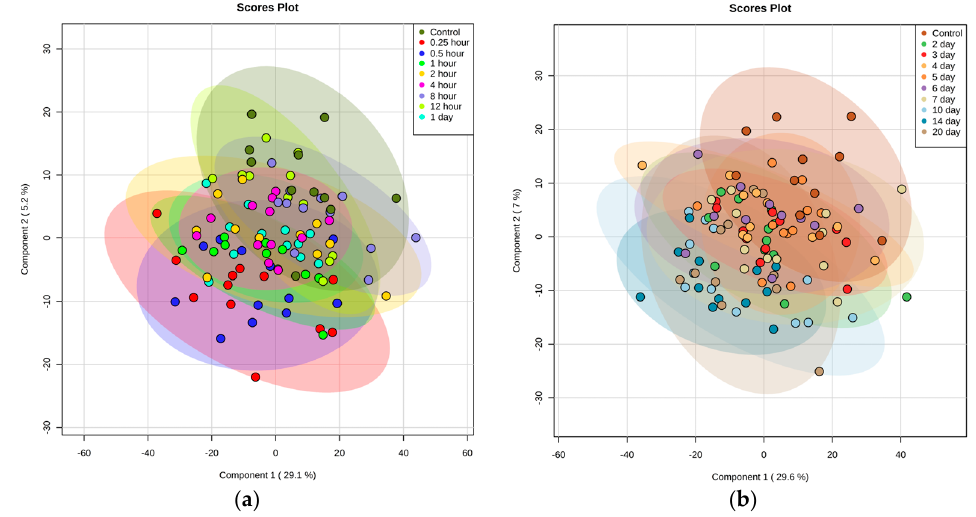
Figure 1. Partial least squares-discriminant analysis (PLS-DA) plots representing biomarkers separation. Multivariate analysis showing metabolic profiles across all Gamma-tocotrienol (GT3)-treated nonhuman primates (NHPs) separated in two time intervals: ( a ) short-term (first 24 h) with R 2 = 0.52 and Q 2 = 0.19, and ( b ) long-term (2 days to 20 days) with R 2 = 0.43 and Q 2 = 0.0.07. Both groups demonstrate minimal separation, indicating no significant changes amongst groups treated with GT3.